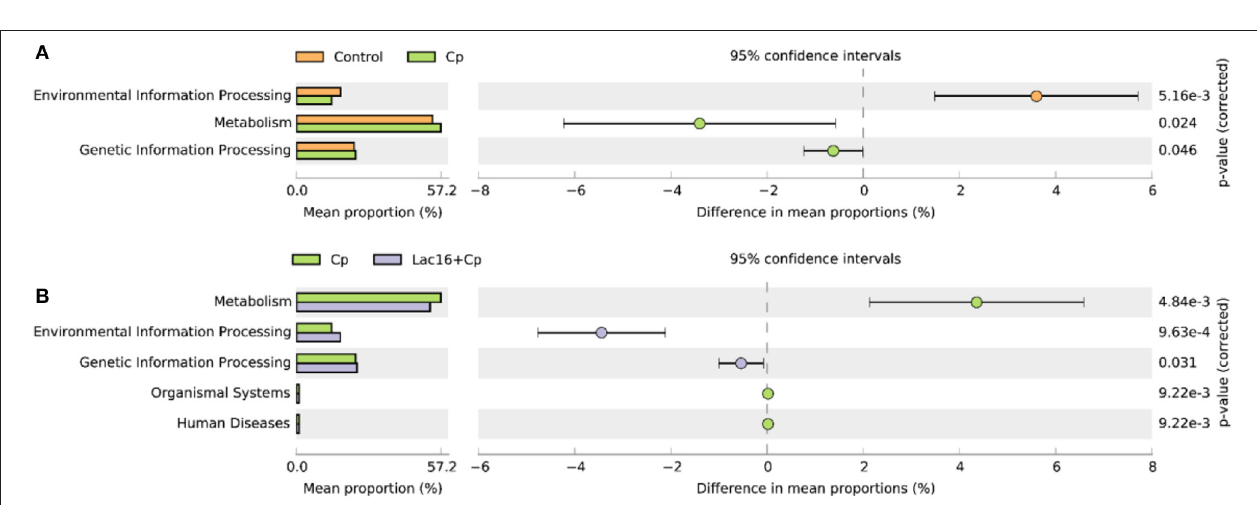
and tetracycline biosynthesis, whereas negatively ( p < 0.05, p < 0.01, or p < 0.001) correlated with glycan biosynthesis